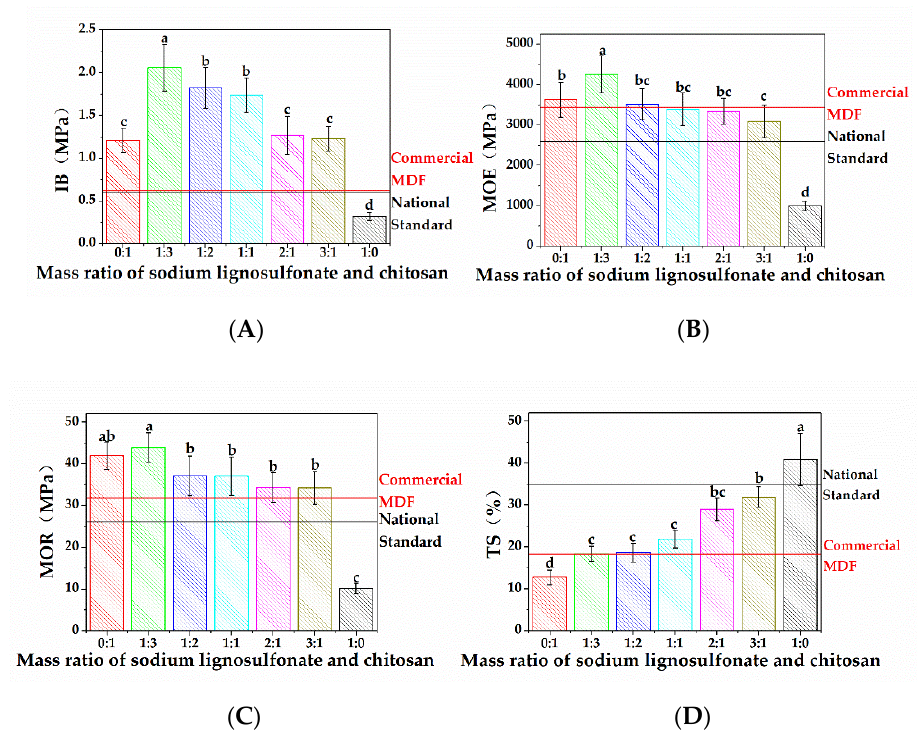
Figure 6. ( A ) Influence of sodium lignosulfonate content on internal bond strength (IB); ( B ) Influence of sodium lignosulfonate content on modulus of elasticity (MOE); ( C ) Influence of sodium lignosulfonate content on modulus of rupture (MOR); ( D ) Influence of sodium lignosulfonate content on thickness swell (TS).